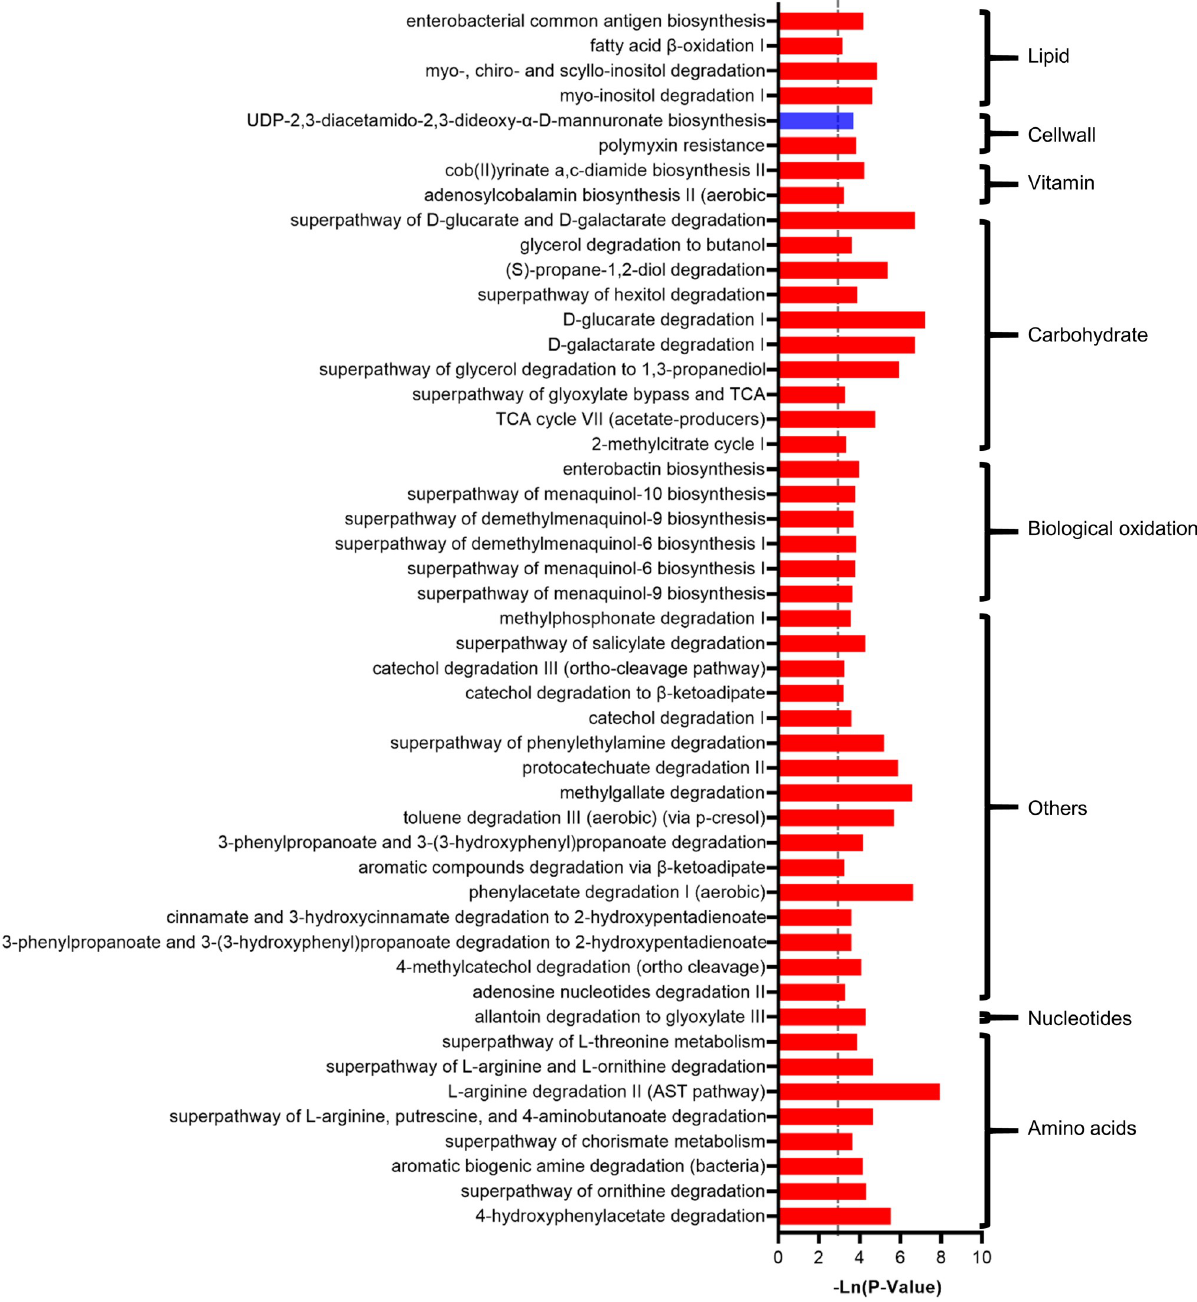
Fig 2. The effect of cat ownership on the function of the microbiota of all individuals. The significant effect of cat ownership on microbial metabolism pathways.